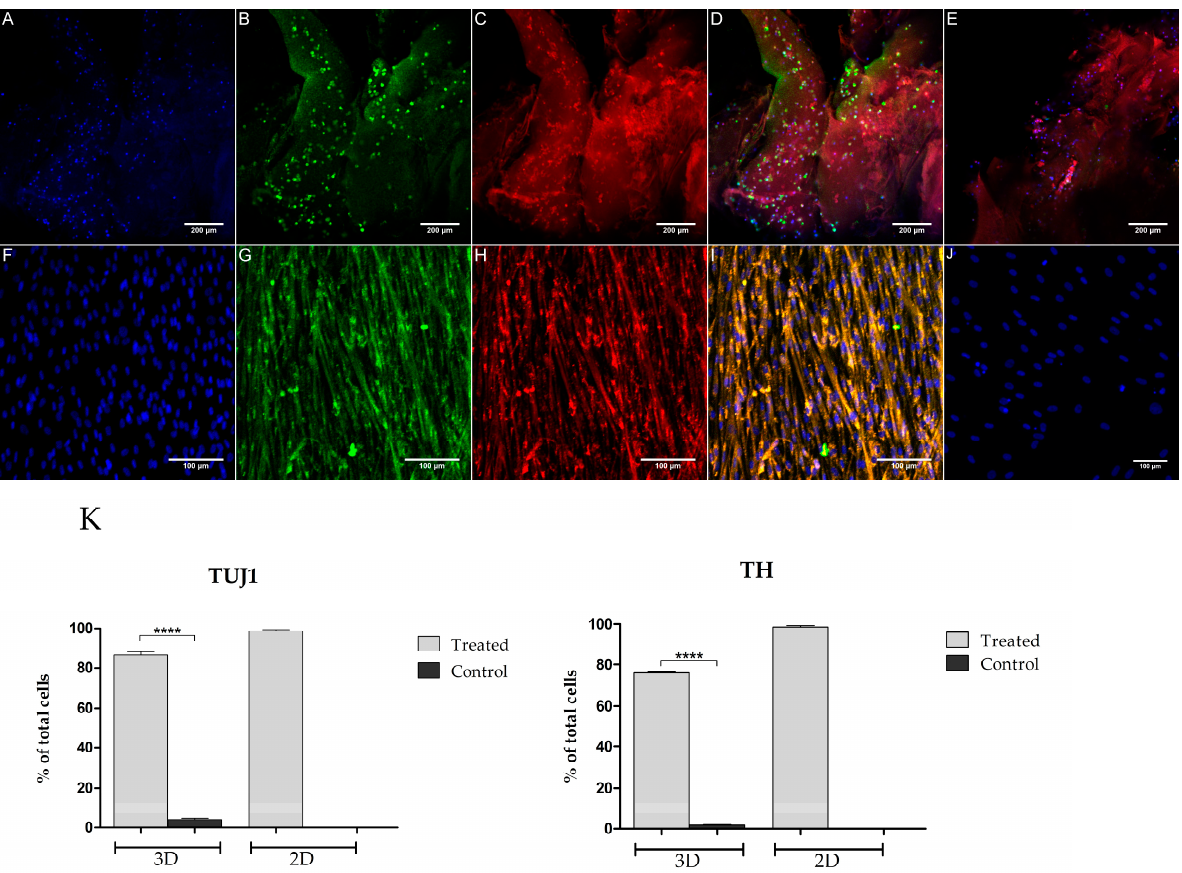
Figure 5. Immunocytochemistry of 3D ( A – E ) and 2D ( F – J ) cell cultures after 12 days of differentiation. In 3D, the experimental group ( A – D ) and control group ( E ) were imaged at 20 × ; In 2D, the experimental group ( F – I ) was imaged at 10 × and control group ( J ) was imaged at 20 × . Scale bar represents 200 µ m for 3D culture, and 100 µ m for 2D culture. The quantitative results for the number of TUJ1-positive and TH-positive cells are seen in ( K ). A two-tailed Student’s t -test, with a confidence level of 95% ( p < 0.05), was conducted to determine the statistical significance between the control and experiment groups; **** p <